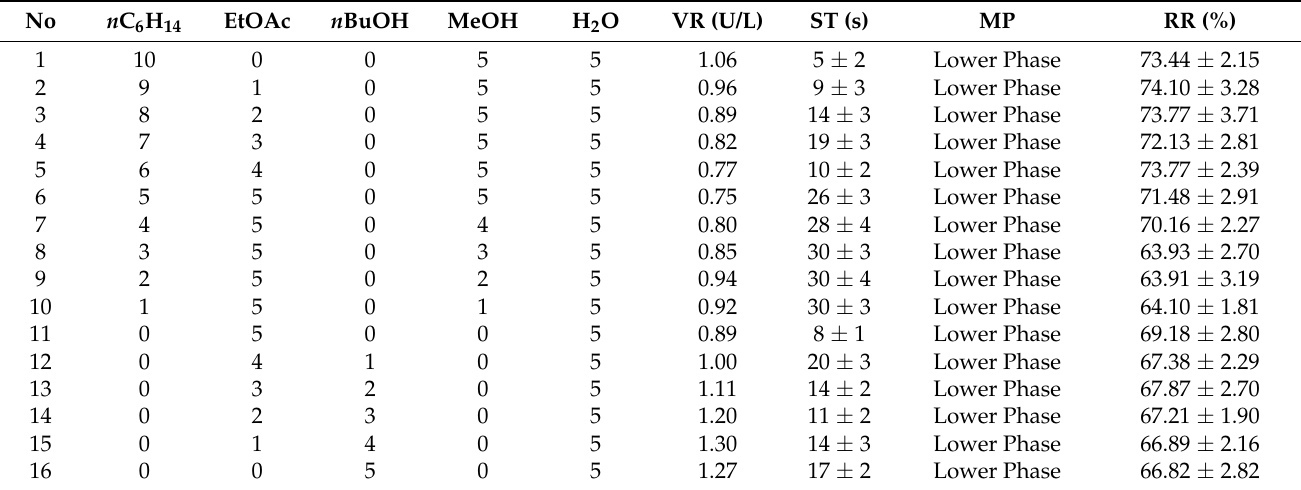
Table 1. The retention rate of classic n -hexane–ethylacetate–methanol–water solvent system.